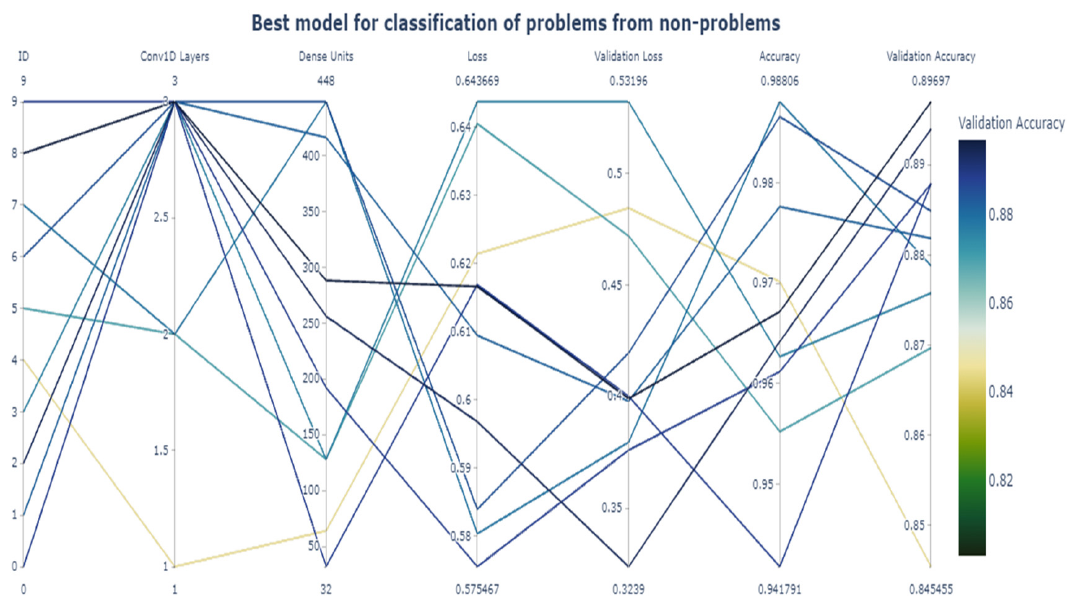
Figure 3. Hyperparameter tuning results for the classification of problems from non-problems. Table 10. Hyperparameter tuning results for the classification of problems from